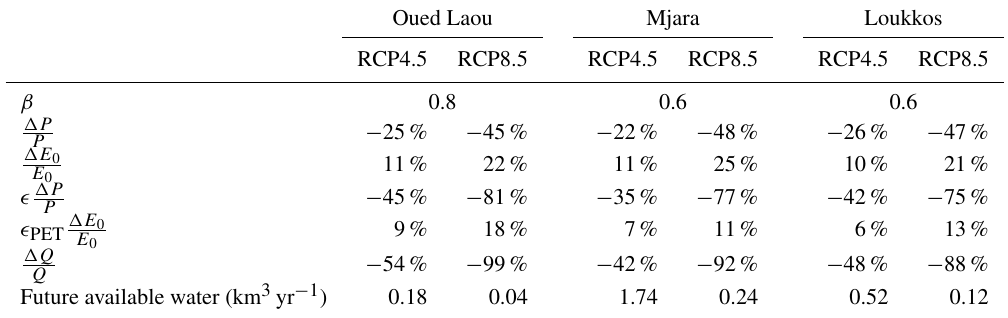
Table 8. Summary of runoff sensitivity to precipitation and PET under climate change using the mean of the multi-model simulations and the estimation of the future total available water in the region. Oued